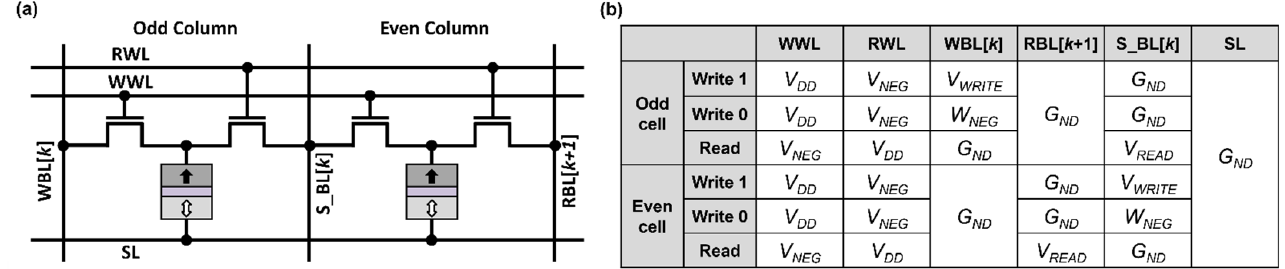
Figure 5. ( a ) Proposed 1R/1W STT-MRAM bit-cell schematic and ( b ) biasing condition for write and read operations.